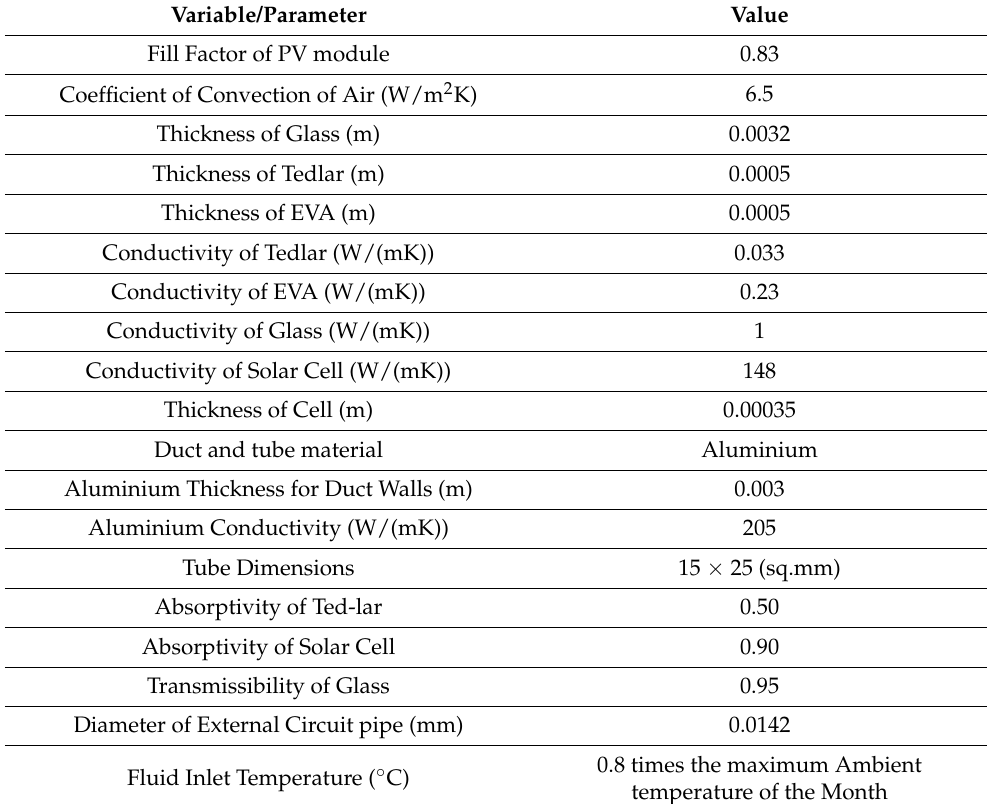
Table 2. Predefined variables/parameters for analytical calculations